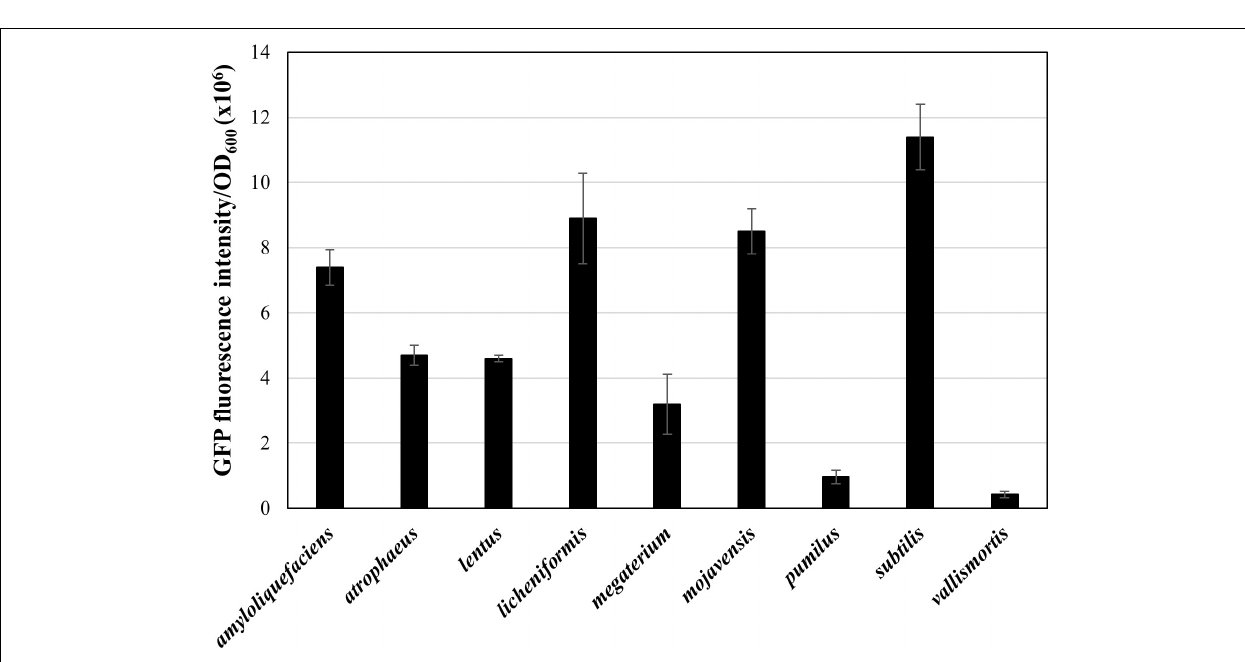
FIGURE 3 | Expression of GFP in 41 undomesticated B. subtilis strains. The GFP fluorescence reading was normalized to OD 600 = 1. The bars display the means of three independent measurements, with the error bars indicating standard deviations.